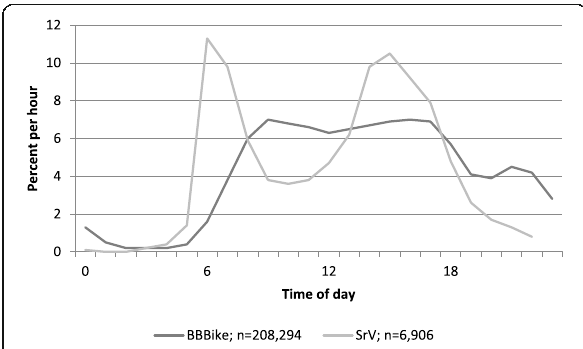
Fig. 2 Distribution of BBBike requests over the course of the day compared with the municipal survey. Both curves show the average for weekdays Tuesday to